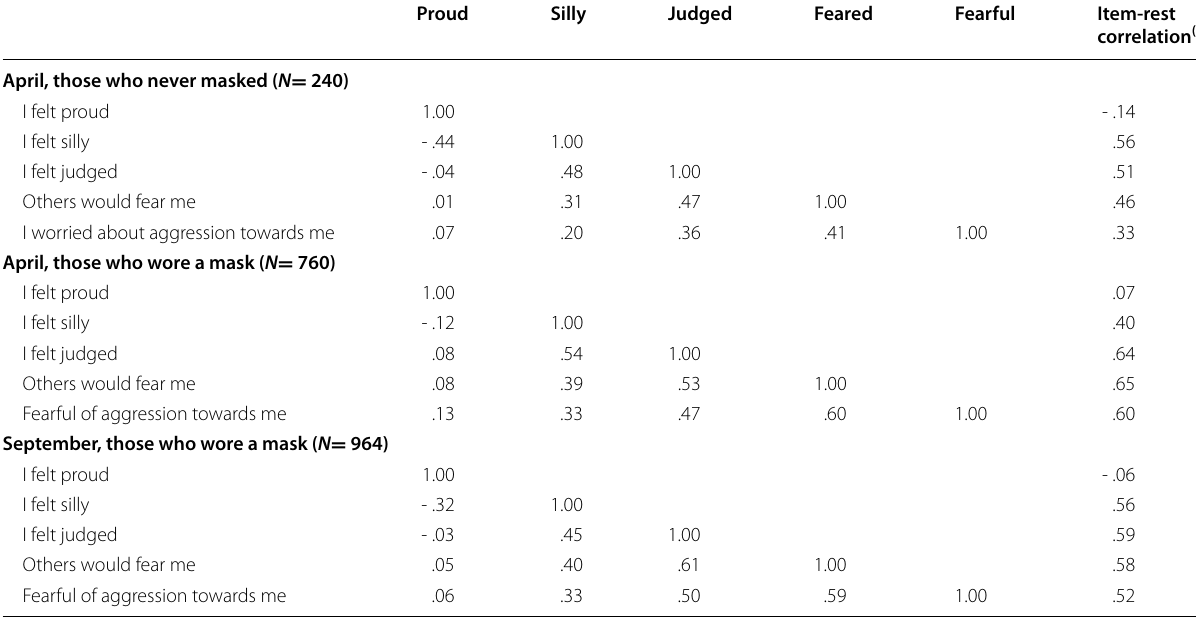
a The item-rest correlation is the Pearson correlation of each item with a scale created by adding together the standardized scores of the other four items